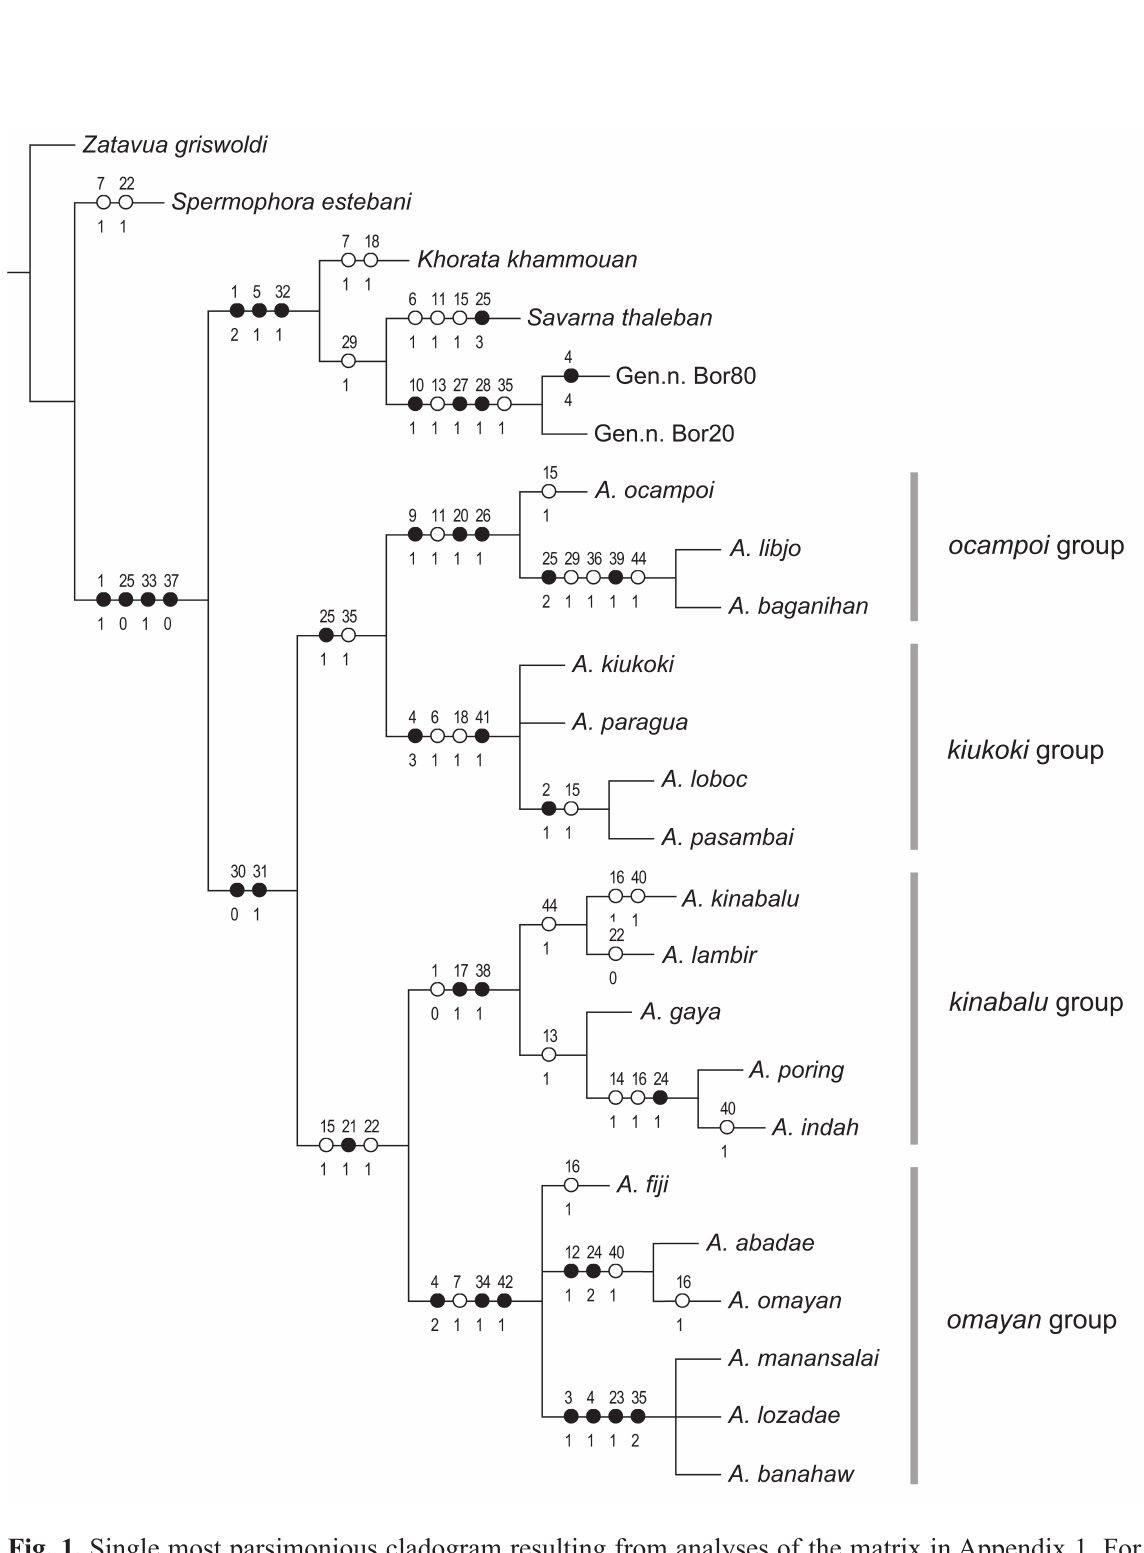
Fig. 1. Single most parsimonious cladogram resulting from analyses of the matrix in Appendix 1. For characters and character states see Appendix 3. Only unambiguous character changes are shown. See Cladistic analysis section for further